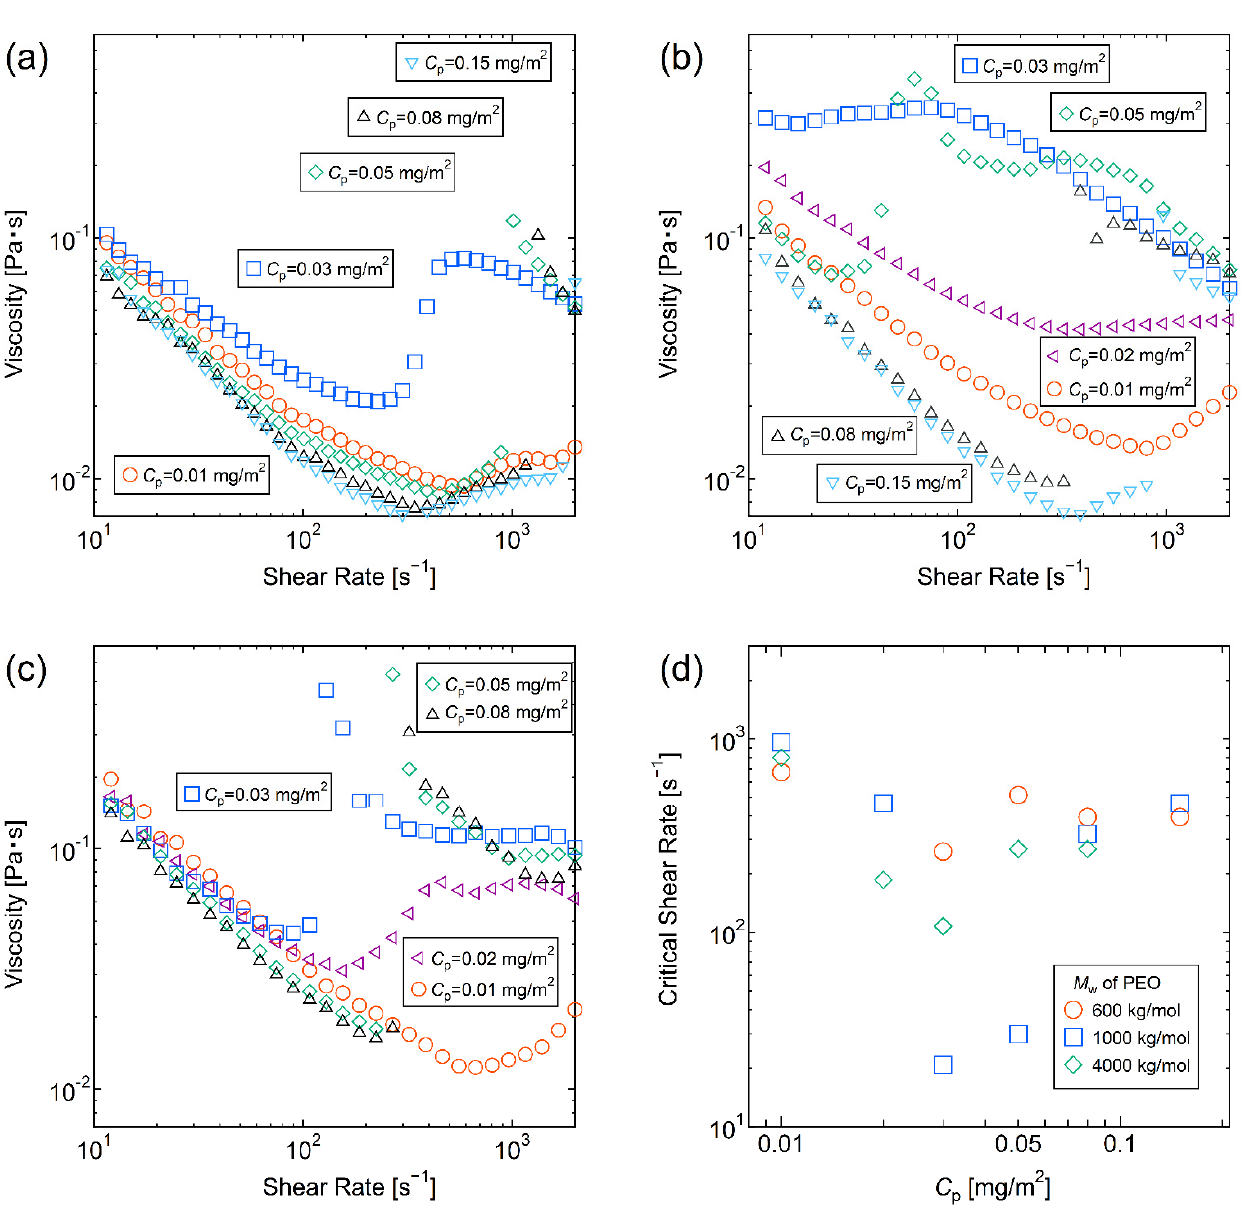
Figure 2. ( a – c ) Viscosities were plotted against the applied shear rate at different C p values. The molecular weights of PEO were ( a ) 600 kg/mol, ( b ) 1000 kg/mol, and ( c ) 4000 kg/mol, respectively. ( d ) Critical shear rates were plotted against the C p values at different PEO molecular weights. The PEO molecular weights were ( ○ ) 600 kg/mol ( □ ), 1000 kg/mol, and ( △ ) 4000 kg/mol, respectively.